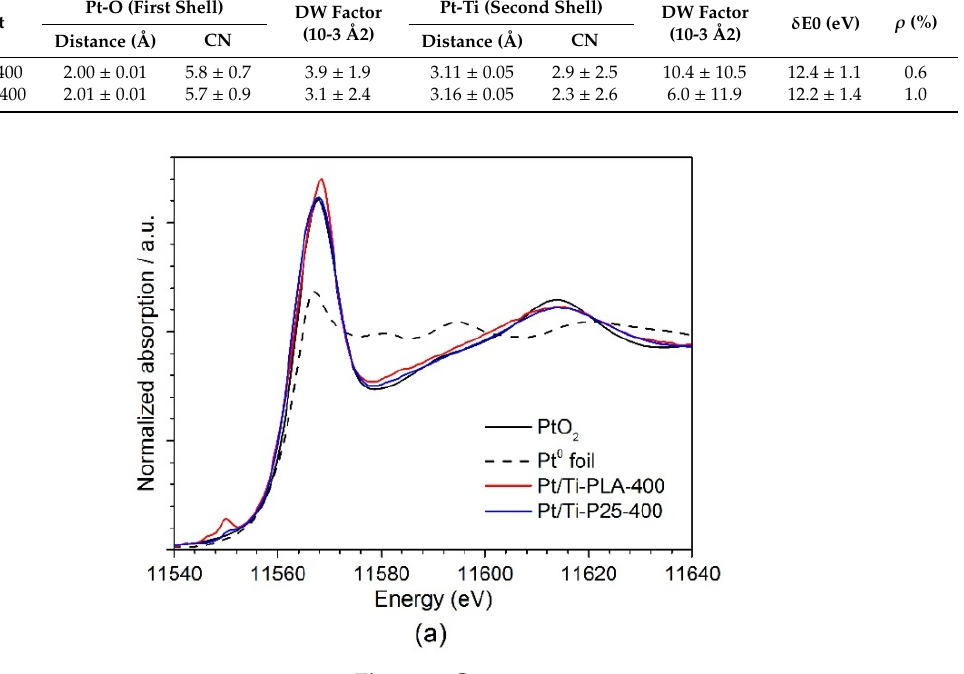
Table 2. Results of extended X-ray absorption fine structure (EXAFS) fitting to a structural model